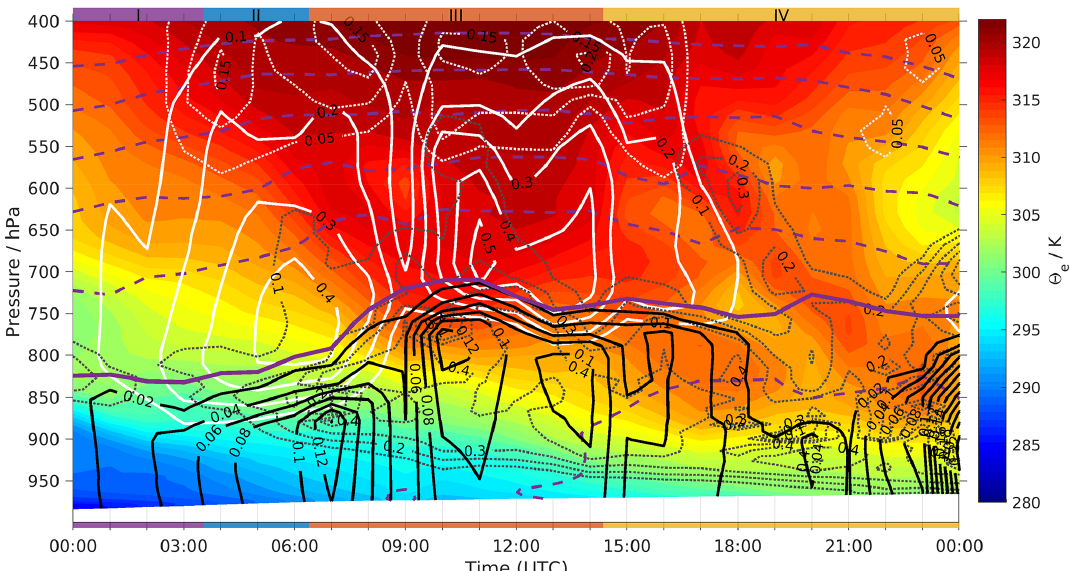
Figure 6. Hourly equivalent potential temperature from ERA5 reanalysis for the observation site at Bergen between 00:00UTC 7 December and 00:00UTC 8 December 2016. The solid white line indicates specific snow water content and the dotted white line specific cloud ice water content. The solid black line indicates specific rain water content and the dotted black line specific cloud liquid water content. The unit of all contours for different water species isgkg − 1 . The thick purple line indicates the 0 ◦ C isothermal line, and dashed purple lines indicate isothermal lines deviating from the 0 ◦ C isothermal line with 5 ◦ C intervals. Colour bars at the top and bottom indicate precipitation periods